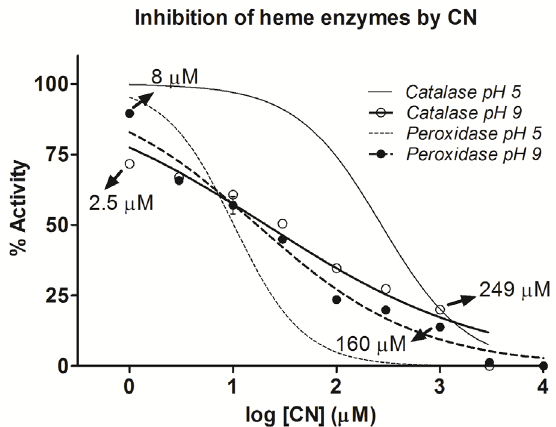
Figure 3: Data points for CN sponsored inhibition of the formation of purpurogallin (resulting from the one-electron oxidation of pyrogallol) by horseradish peroxidase (HRP) and bovine catalase at pH 9. Functional K values estimated at the respective four points d (marked with arrows) seem to erroneously indicate that “affinity” increases at low cyanide concentrations. The functional K shows a d 100 fold and 20 fold lowering when CN concentration is changed by three orders of magnitude, from 1 mM to 1 μM, for catalase and HRP respectively. [HRP or Catalase] = 2 nM; [Pyrogallol or H O ] = 2 mM. 2 2 Abrupt enhancement of inhibition is seen at CN > 1mM. The non- linear regression plots of the reactions at pH 5 are also provided, to enable a comparison of Hill Slopes. 5 (left panel), the column voided at 2.5 to 3 minutes, whereas the completely separated ATP and ADP eluted at 5.6 and 6.5 minutes respectively. The standard plot of the